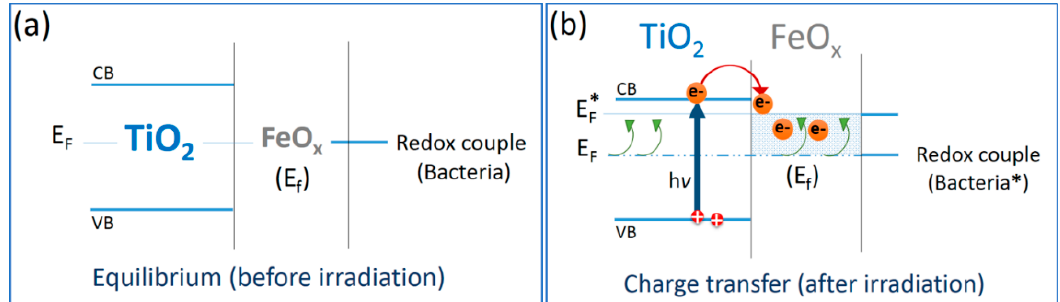
Figure 8. ( a ) IFCT leading to bacterial inactivation under visible light induced by co-sputtered by TiO 2 –FeO x –PE films. For further details, see the text. ( b ) Simplified mechanism for bacterial inactivation by sequentially sputtered TiO 2 /FeO x –PE films under visible light. For further details, see the text.